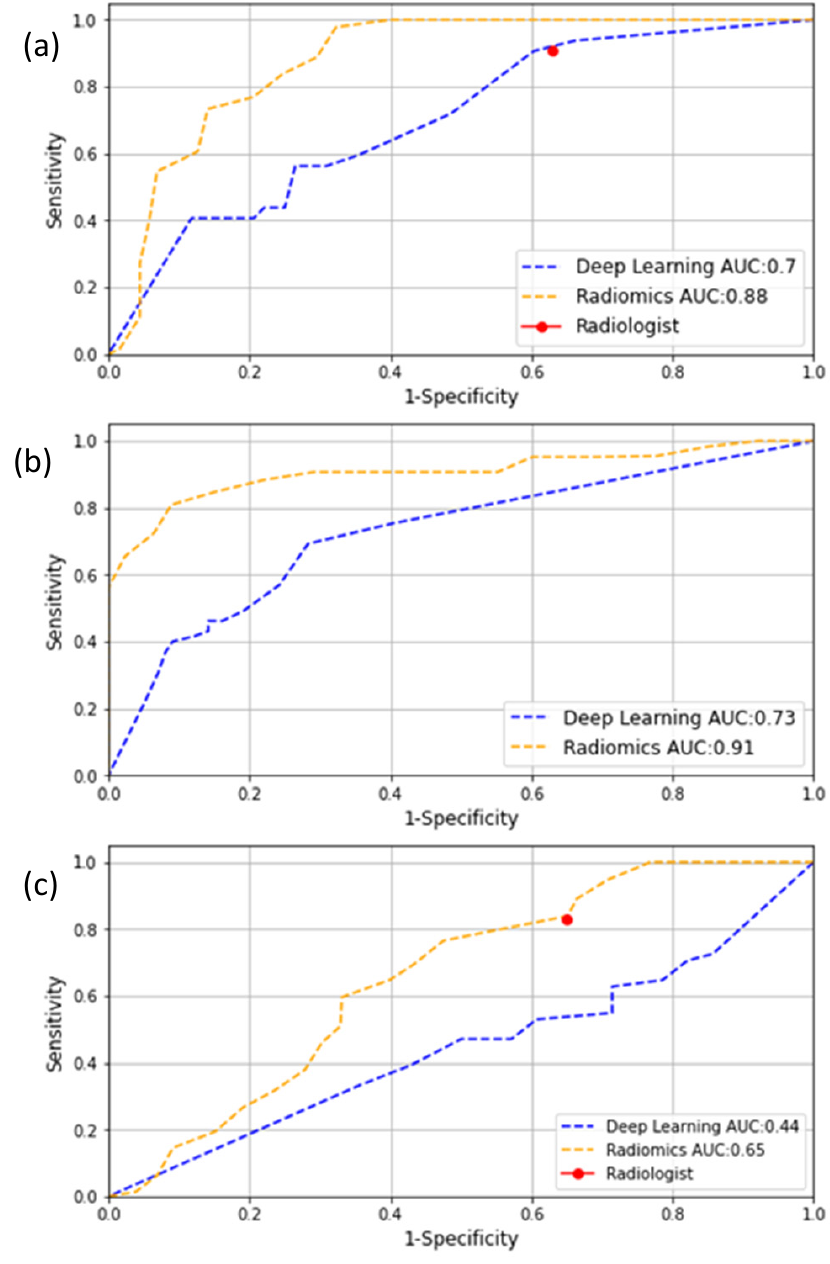
Figure 3. ROC curves of the deep-learning (blue) and radiomics (orange) models when evaluated on the test sets: ( a ) Prodrome, ( b ) ProstateX and ( c ) PCMM.